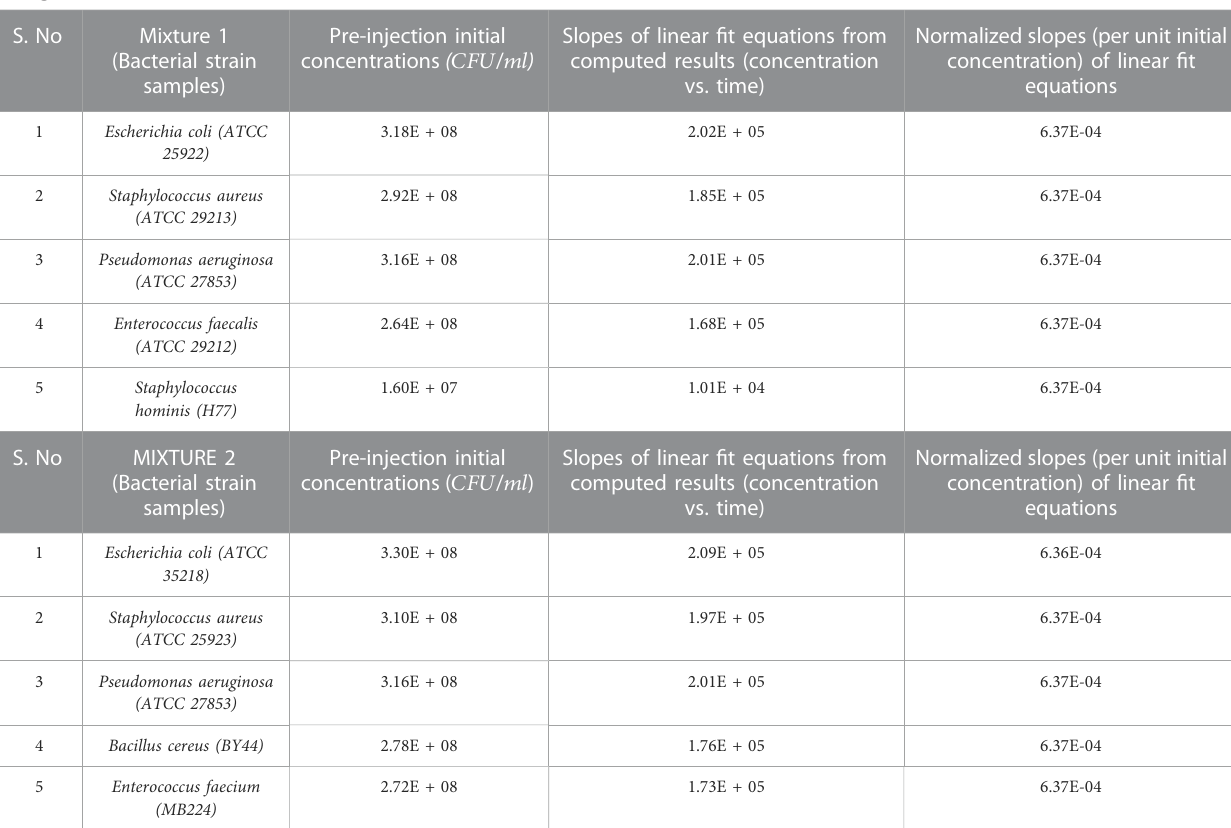
TABLE 5 Trial details highlighting the two mixtures of bacteria, their composition, pre-injection concentrations, for each of the runs along with the slopes of the linear fi t equations from predicted results of concentrations of individual species as a function of time, and the normalized slopes (per unit initial concentrations) oflinear fi tequations.Theslopesoflinear fi tequationsareconsistentwiththepre-injectioninitialconcentrationsofindividualspeciesofthemixtureofscatterers present in the scattering volume of interrogation. The normalized slopes of individual species in the mixtures are identical, showing the dependence only on the average concentration of the mixture in each